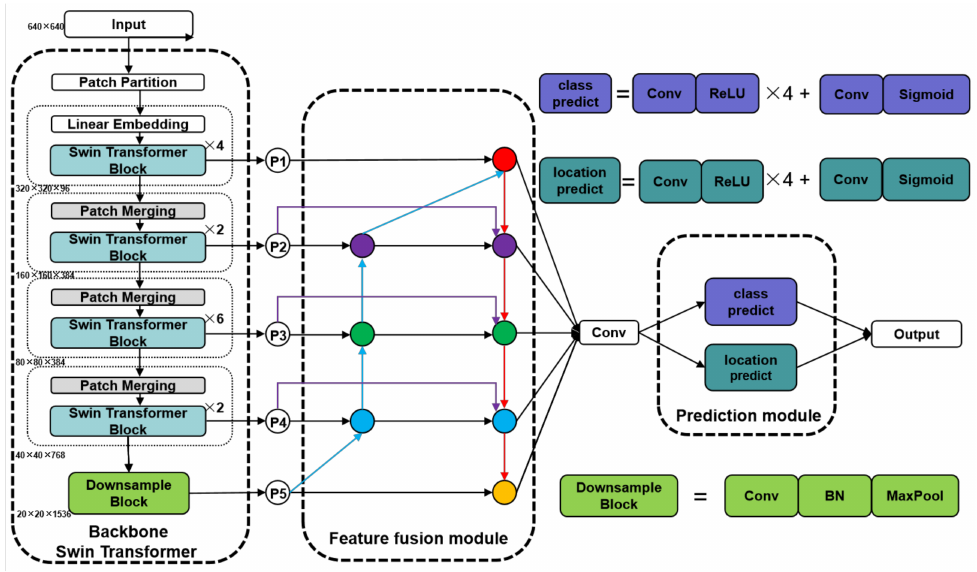
Figure 2. Overview of the